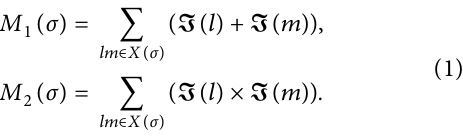
molecular graph of σ . Te total number of vertices ( q ) and 2 edges ( p ) in the structure of Benzenoid planar octahedron are 45 n 2 − 3 n and 90 n 2 . end vertices. Te frst edge partition includes of 36 n 2 edges lm , where I ( l ) � 3 and I ( m ) � 3. Te second edge parti- tion includes of 12 n edges lm , where I ( l ) � 3 and I ( m ) � 4. Te third edge partition includes of 36 n 2 − 12 n edges lm , where I ( l ) � 3 and I ( m ) � 8. Te fourth edge